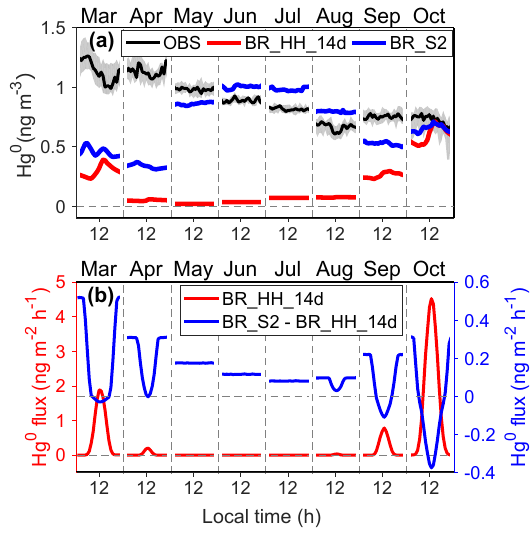
Figure 8. Possible impacts of snow mercury dark reduction on Hg 0 concentrations and fluxes in the non-summer period. Panel (a) shows Hg 0 observations at 25cm above the snow surface at Dome C, and the shaded regions indicate 25% and 75% per- centiles. The modeled Hg 0 concentrations from BR_HH_14d and BR_S2 are also shown. Panel (b) shows the modeled Hg 0 snow-to- air diffusion fluxes from BR_HH_14d (left axis) and the difference of snow-to-air diffusive fluxes between BR_S2 and BR_HH_14d (right